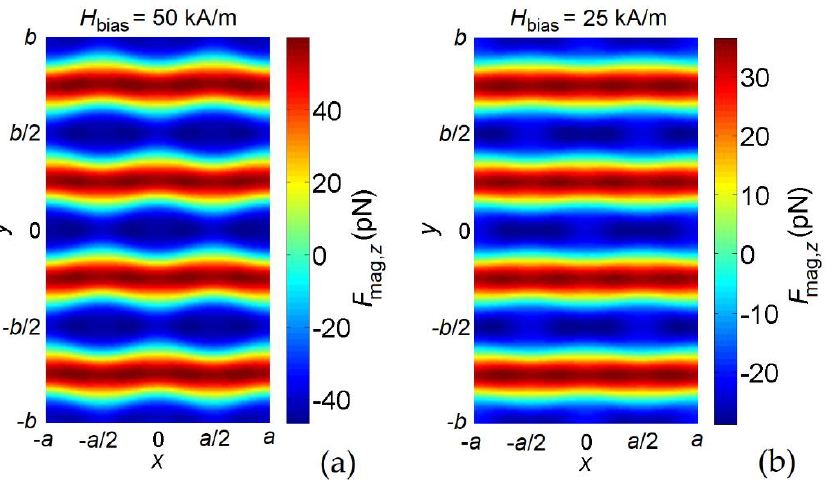
Figure 3. Maps of the vertical component of the magnetic force calculated on a plane parallel to the permalloy nanostructured film for MagSIGNAL-STA beads, applying a bias field of ( a ) 50 kA/m and ( b ) 25 kA/m. The beads are assumed to be in contact with the film surface.